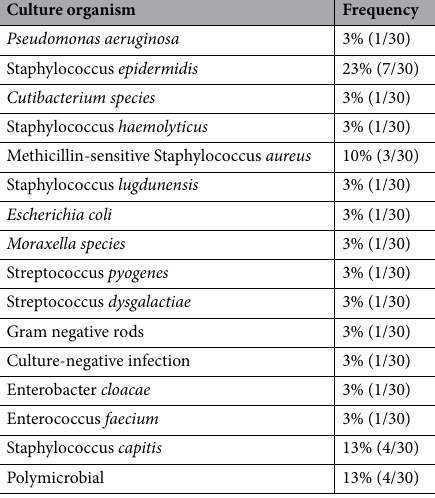
Table 1. List of the identified bacterium in the first stage